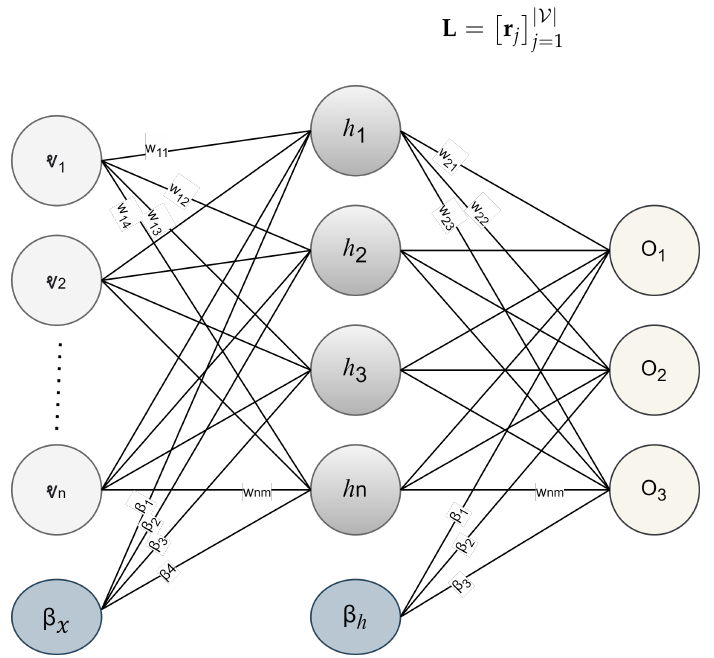
Figure 6. An abstract view of proposed feed forward neural network